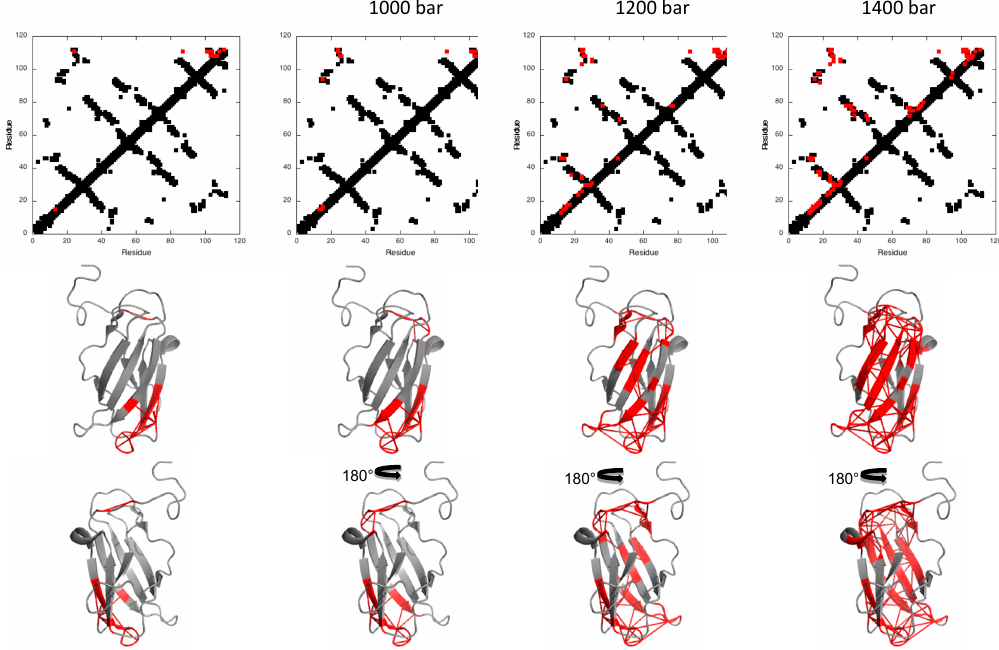
Figure 6. Pressure denaturation of DEN4-ED3. (Top) Contact maps built from the solution structure obtained DEN4-ED3 [15] at 600, 1000, 1200, and 1400 bar, as indicated. The contacts above the diagonal have been colored in red when contact probabilities ( Pij ) lower than 0.5 are observed. (Bottom) Ribbon representations of the solution structure DEN4-ED3 where the red ticks represent contacts that are weakened ( Pij ≤ 0.5) at the corresponding pressures.